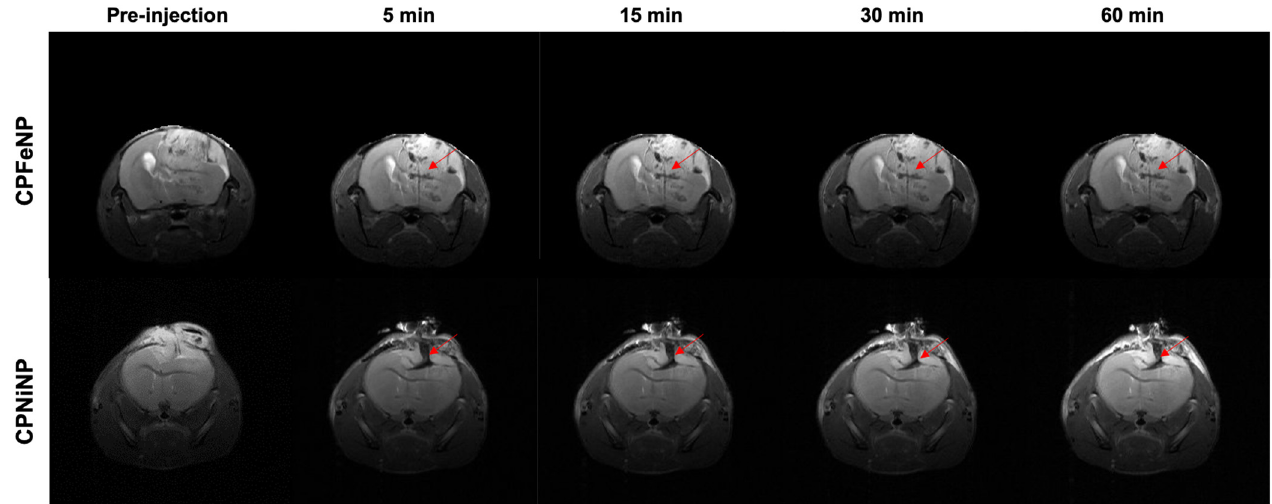
Figure 6. MRI monitoring after i.t. injection of IONP-doped CPNs in the brain. T 2 W axial images of the brain were acquired at 5, 15, 30 and 60 min after the i.t. nanoparticles injection. Red arrows point to the tumor region where the nanoparticles can be identified as a hypointense signal.